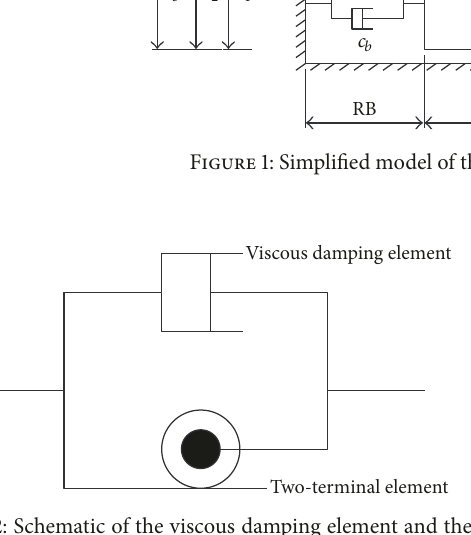
Figure 2: Schematic of the viscous damping element and the two- terminal inerter